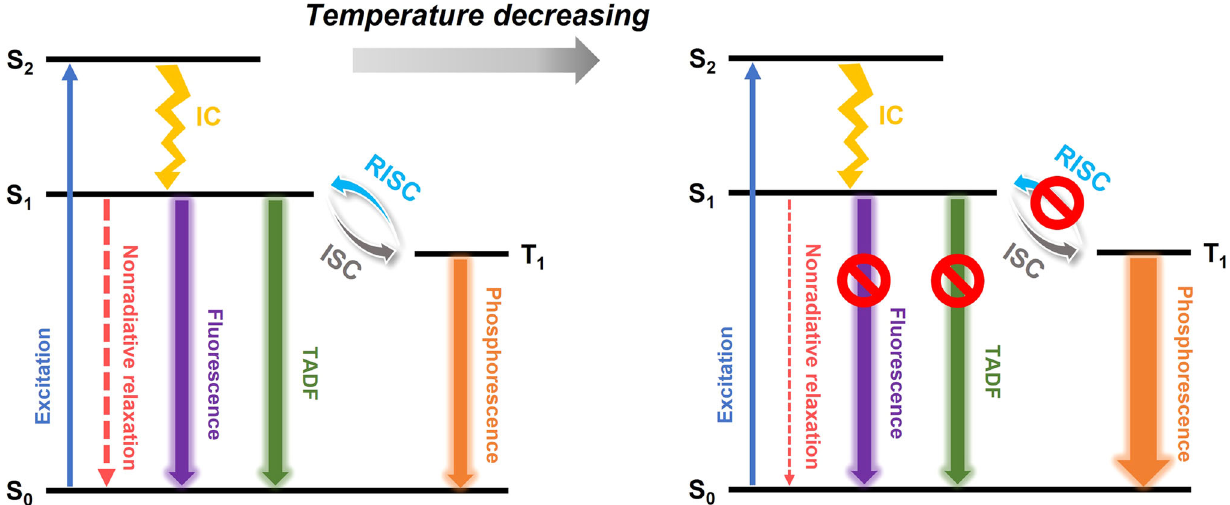
Fig. 4 Proposed emission mechanism of Au 38 (PET) 26 . (IC internal conversion, S 0 ground state, S 1 and S 2 are the excited states, T 1 the lowest triplet